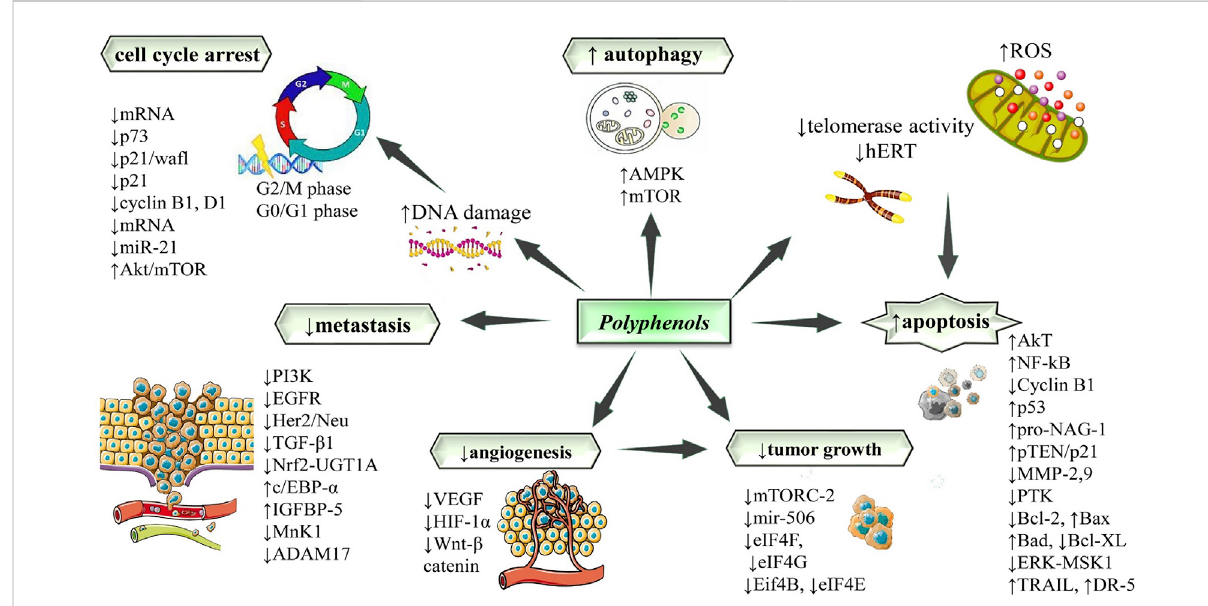
FIGURE 2 Potential molecular targets and signaling pathways for the antitumor effect of polyphenols. Symbols: ↑ increase, ↓ decrease. Abbreviations: ADAM17, ADAM metallopeptidase domain 17; Akt/mTOR, protein kinase B/mammalian target of rapamycin; AMPK, adenosine monophosphate- activated protein kinase; BAD, Bcl-2 antagonist of cell death; Bax, Bcl2-Associated X Protein; Bcl-2, B-cell leukemia/lymphoma 2 protein; Bcl-xL, B-cell lymphoma-extra large; c/ebp- α , CCAAT/enhancer-binding protein-alpha; DR-5, death receptor 5; EGFR, epidermal growth factor receptor; ERK/MSK, extracellular signal-regulated kinase/mitogen- and stress-activated kinase 1; Her2/Neu, human epidermal growth factor receptor 2/neutrophills; HIF-1-alpha, hypoxia-inducible factor 1-alpha; IGFBP-5, insulin-like growth factor-binding protein-5; hTERT, human telomerase reverse transcriptase; miR, microRNA; MMP, matrix metalloproteinase; MnK-1, a family of serine/threonine kinases; mRNA, messenger ribonucleic acid; mTOR, mammalian target of rapamycin; mTORC2, mTOR Complex 2; NF- κ B, nuclear factor kappa B; Nrf1, nuclear respiratory factor 1; PI3K: phosphatidylinositol 3-kinase; pro-NAG-1, pro-nonsteroidal anti-in fl ammatory drug-activated gene-1; pTEN, phosphatase and TENsin homolog deleted on chromosome 10; PTK, protein tyrosine kinase; TGF- β 1, transforming growth factor- β 1; TRAIL, tumor-necrosis factor related apoptosis-inducing ligand; UGT1A, UDP glucuronosyltransferase1 family; VEGF, vascular endothelial growth factor receptor;Wnt,wingless- related integration